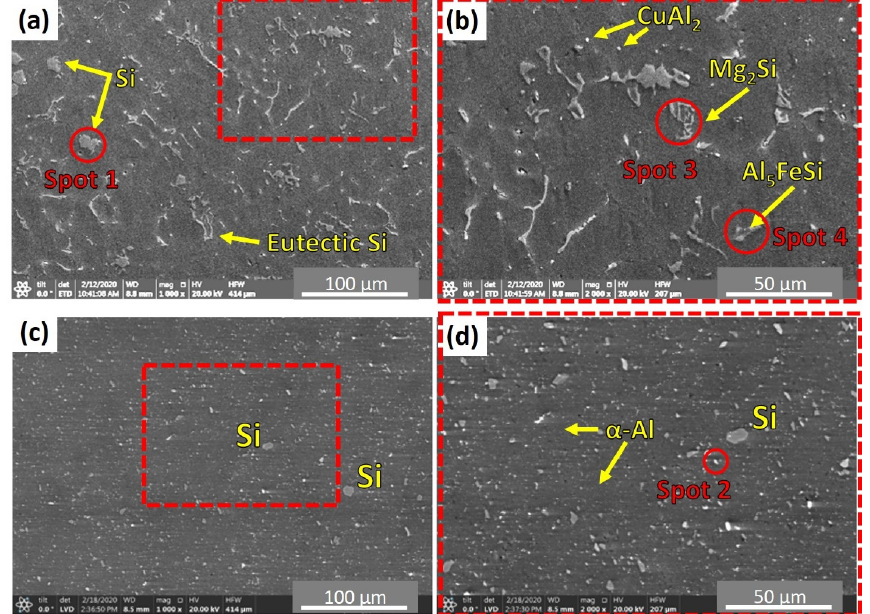
Figure 12 . SEM micrographs for the as cast alloy ( a ) low magnification and ( b ) higher magnification, for the AMP deposited at 3 mm/min and 1200 rpm ( c ) low magnification and ( d ) higher magnification. Note: ( a , b ) are SE, while ( c , d ) are BSE.